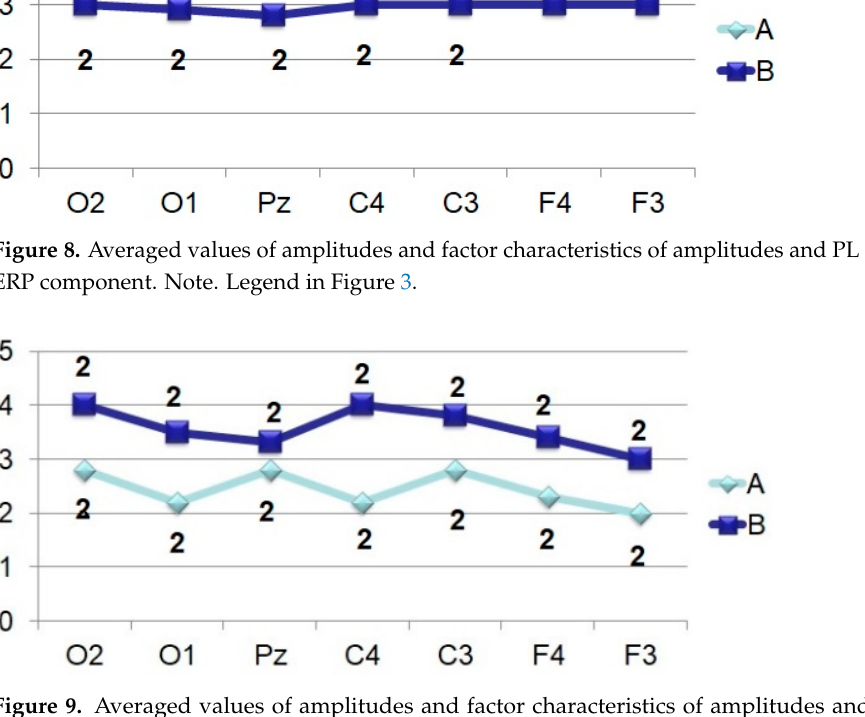
Figure 9. Averaged values of amplitudes and factor characteristics of amplitudes and PL of the N 900 ERP component. Note. Legend in Figure 3.